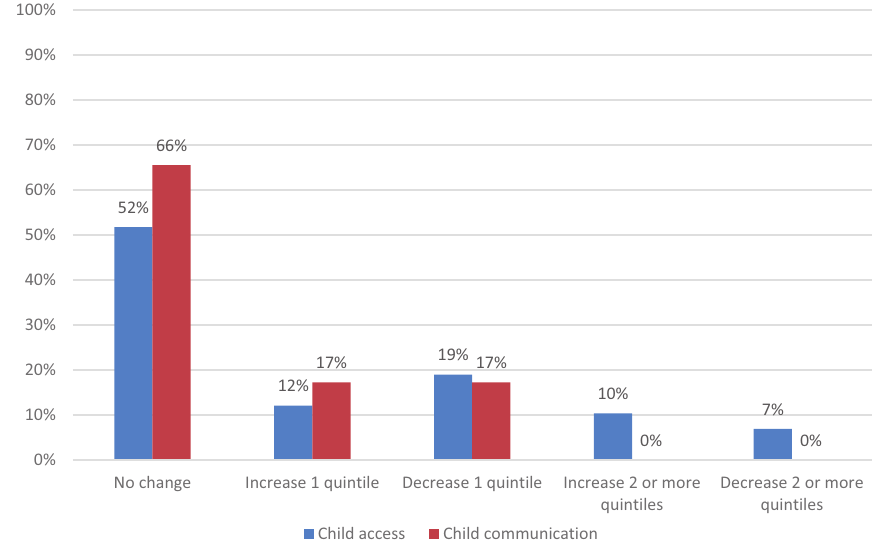
Figure 2. Change in practices’ quintile ranking from original to revised child composites, CAHPS PCMH 2013 ( n = 58 practices).